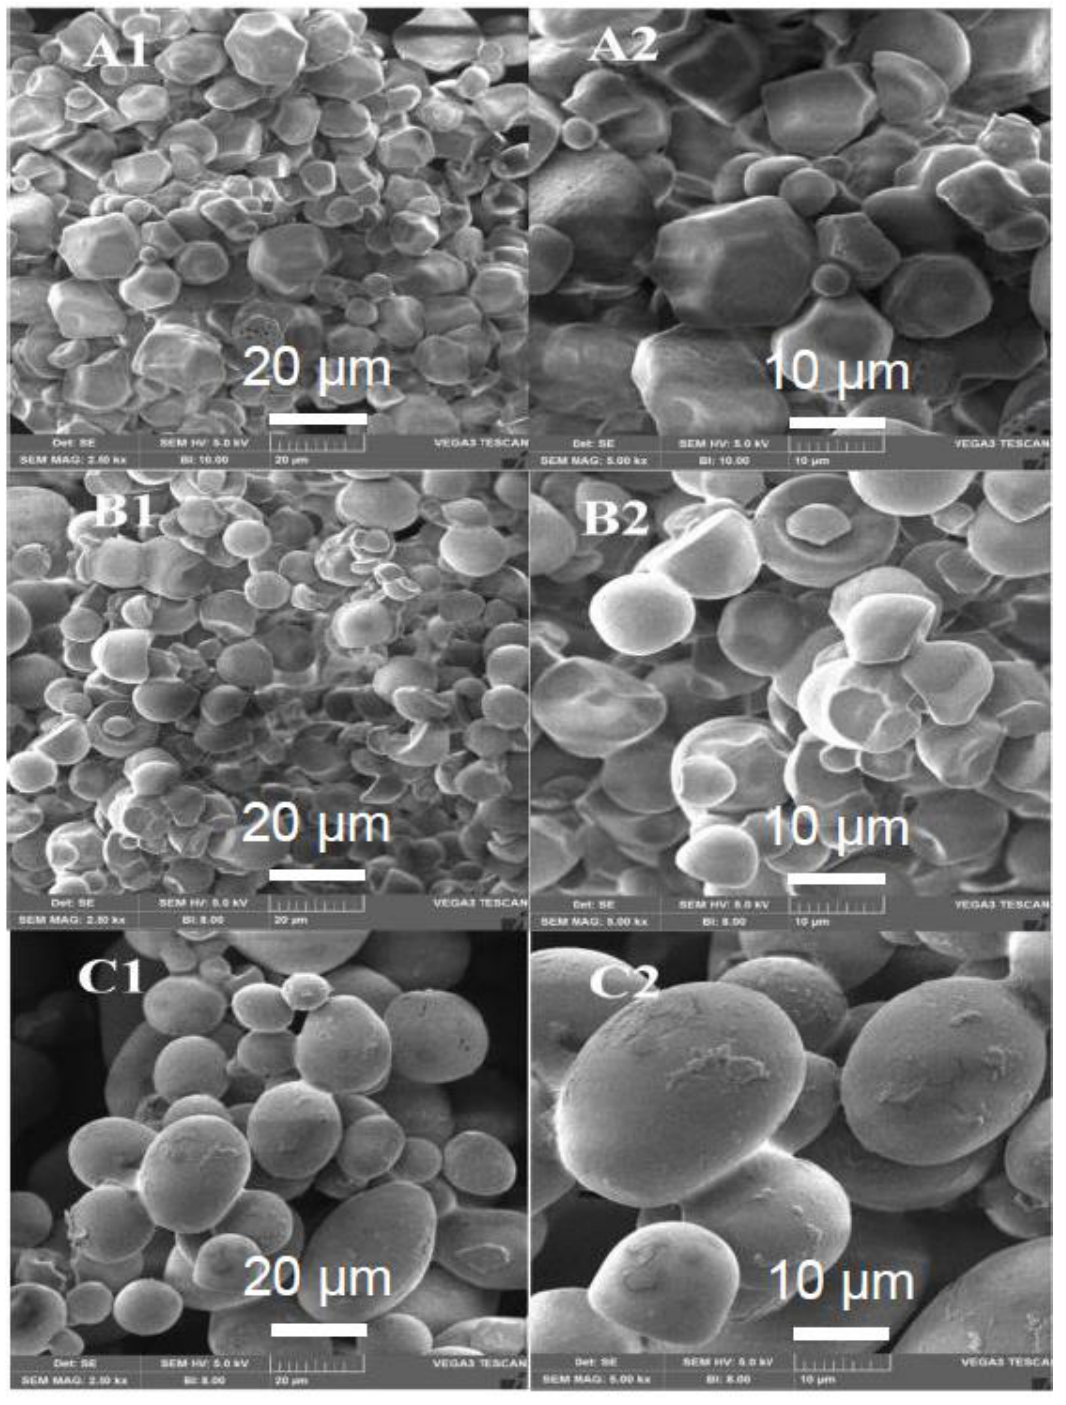
Figure 1. Scanning electron photomicrographs of the powders formed in the spray drying of the enzymatic extract with the carriers: corn starch ( A1 , A2 ), cassava starch ( B1 , B2 ), and soluble starch ( C1 , C2 ). A1, B1, and C1: 2.5 kX magnification; A2, B2, and C2: 5.0 kX magnification.